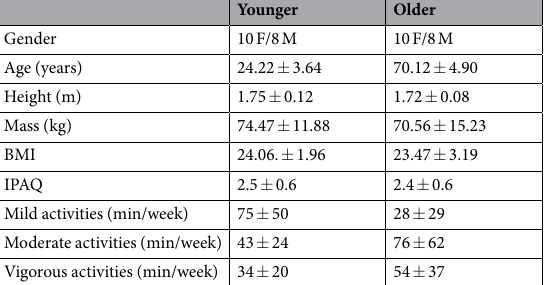
Table 1. Sample demographics, body mass index (BMI), International Physical Activity Questionnaire (IPAQ) score and amount mild, moderate and vigorous activities for younger and older